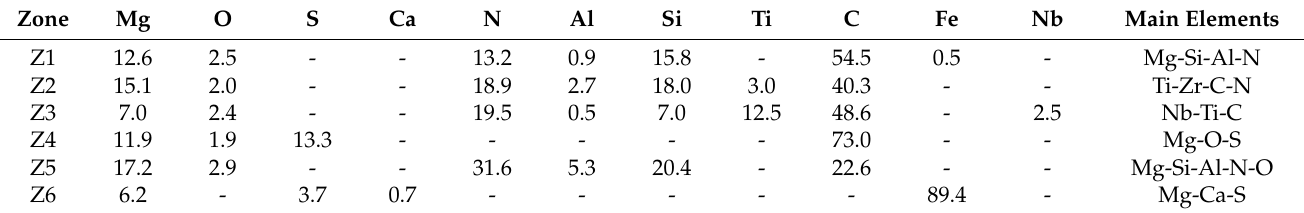
Table 5. EDS chemical composition (at%) of the zones identified in Figure 7.